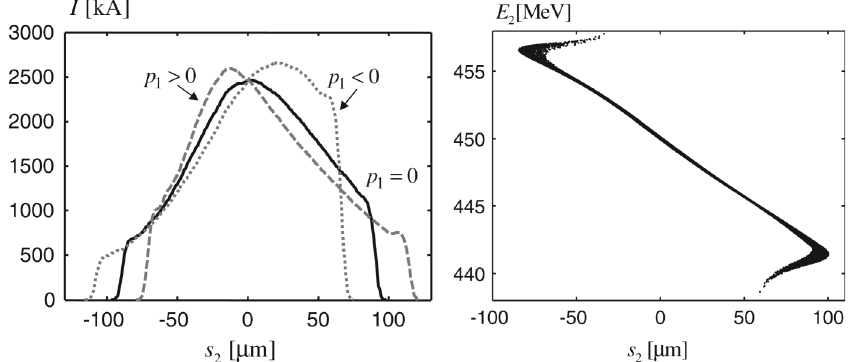
FIG. 7. Impact of the Z 0